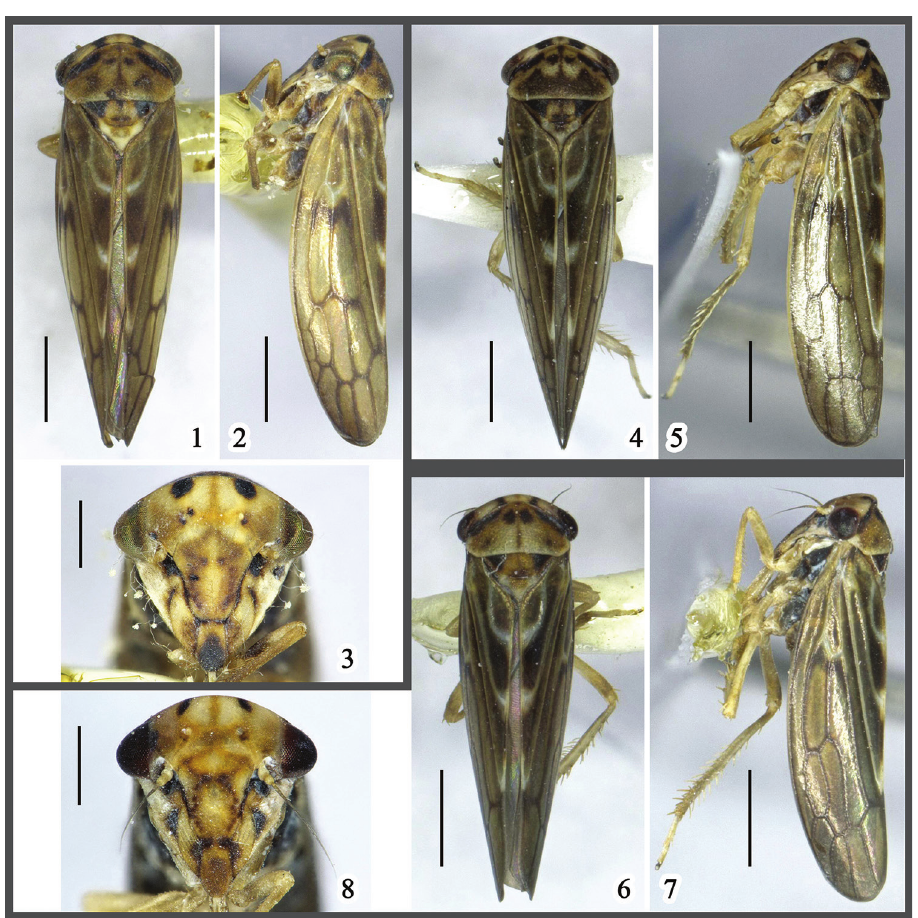
Figures 1–8. Species of Onukigallia , male habitus, dorsal ( 1, 4, 6 ) and lateral ( 2, 5, 7 ) views, and face ( 3, 8 ) 1–3 O . neoonukii sp. n. 4–5 O . onukii (Matsumura, 1912) 6–8 O . tumida sp. n. Scale bars: 1.0 mm ( 1–2, 4–7 ), 0.5 mm ( 3, 8 ). Description. Body coloration . Body background color yellowish brown (Figs 1–3). Crown with darker yellowish stripe on midline, and with one pair of black spots sepa- rating crown into three equal parts. Face (Fig. 3) upper part with two black spots contiguous with those on crown, midline with yellow stripe extending to base of post- clypeus, both sides of midline with white halo; small dark brown macula present ven- trolaterad of ocellus; eyes brown, scattered with yellow markings; area below antennal fossa black; lateral frontal suture pale yellow, clypeal sutures dark brown; anteclypeus, distal half black; gena white. Pronotum yellowish brown, anterior margin with black maculae near eyes, midline dark brown, both sides of midline with small and larger paired dark brown maculae. Mesonotum dark brown, lateral angles and basal part of midline black, sides of midline with two small dark brown maculae on distal